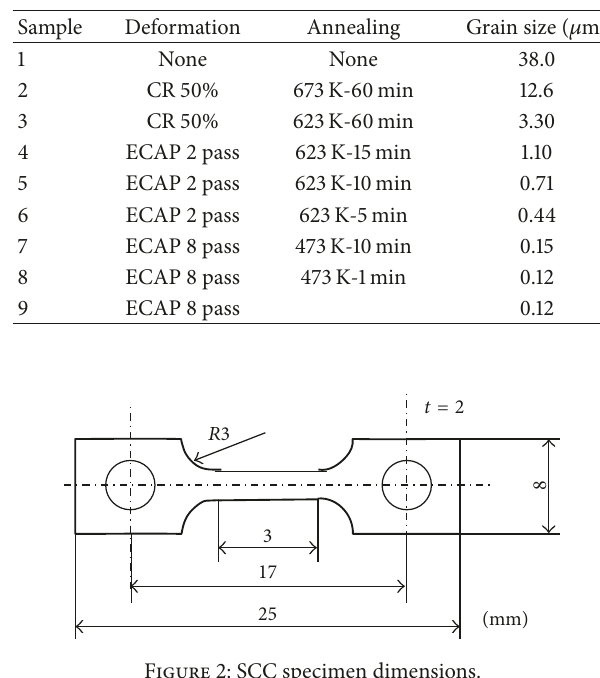
Table 1: Processing recipes and grain size.